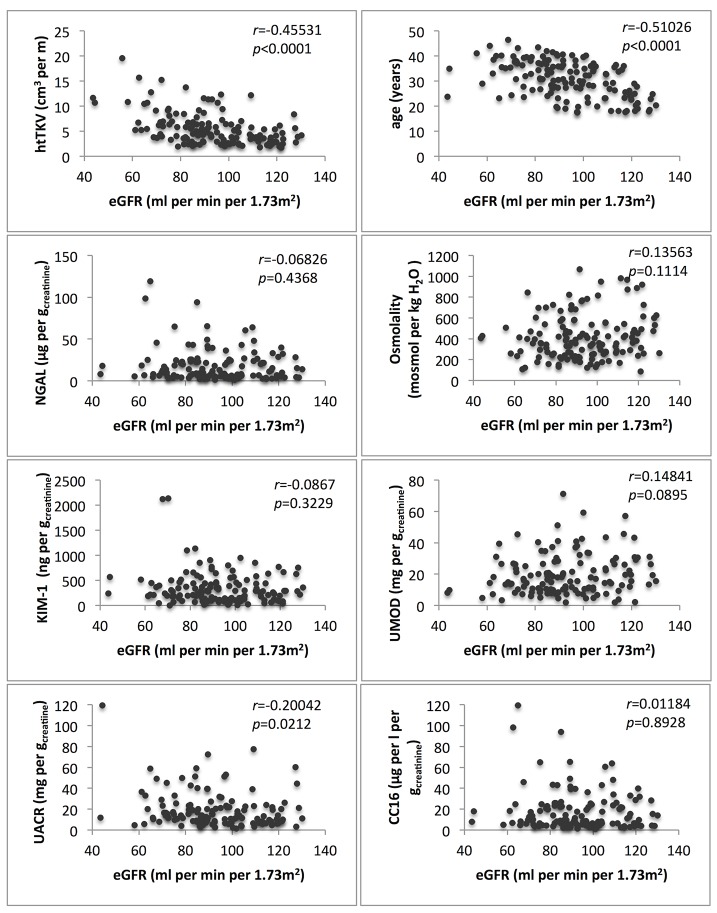
Estimated glomerular filtration rate (eGFR) and parameter distribution.